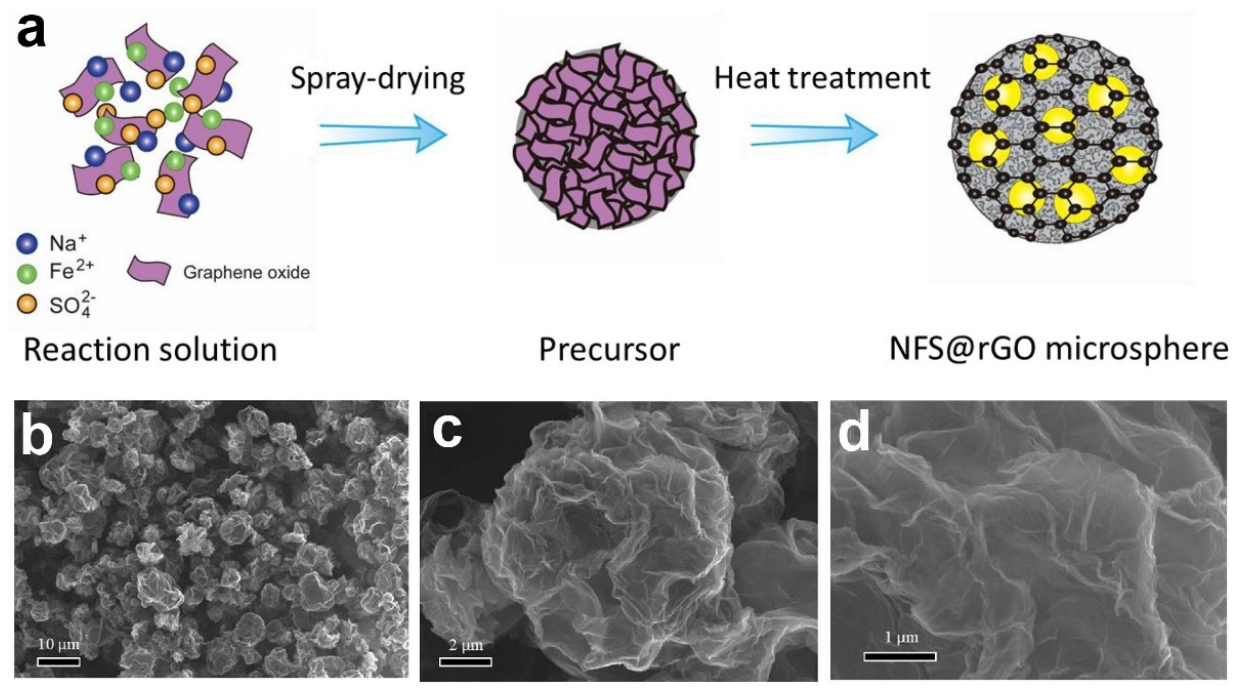
Figure 18. ( a ) The fabrication steps of NFS@rGO microspheres; ( b – d ) SEM images of graphene coated Na 2 . 4 Fe 1 . 8 (SO 4 ) 3 microspheres with different magnifications. Reproduced with permission [99]. Copyright 2021, Elsevier.